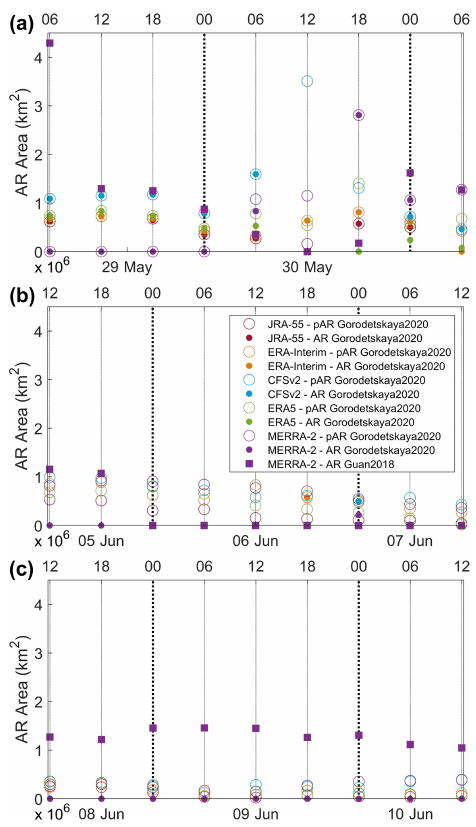
Figure 3. Time series of the area of the AR shape (based on Gorodetskaya2020), of the shape of pARs (IWV ≥ IWV thres , based on Gorodetskaya2020), and of the AR shape (based on Guan2018, only for MERRA-2 reanalysis) during the 30 May event (a) , the 6 June event (b) , and the 9 June event (c) based on reanalyses (ERA- Interim, MERRA-2, ERA5, CFSv2, and